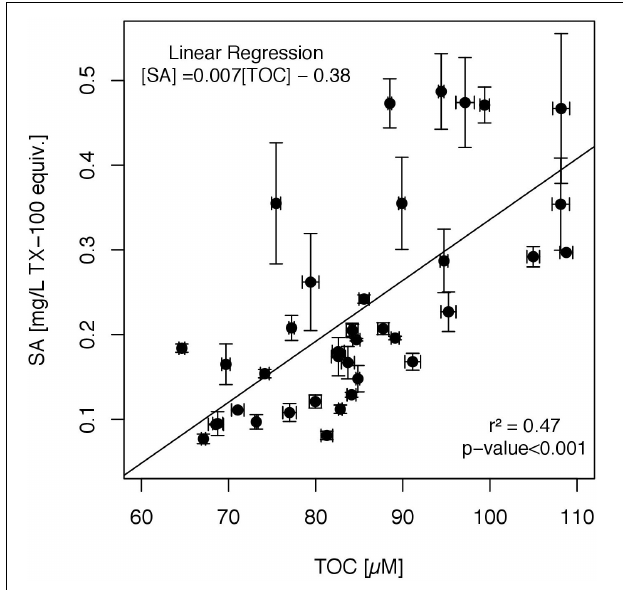
FIGURE 6 | Linear regression model applied for the relation of surface activity (SA) to total organic carbon (TOC), including SML and ULW samples ( N = 38). Whiskers represent the standard errors for SA and TOC.